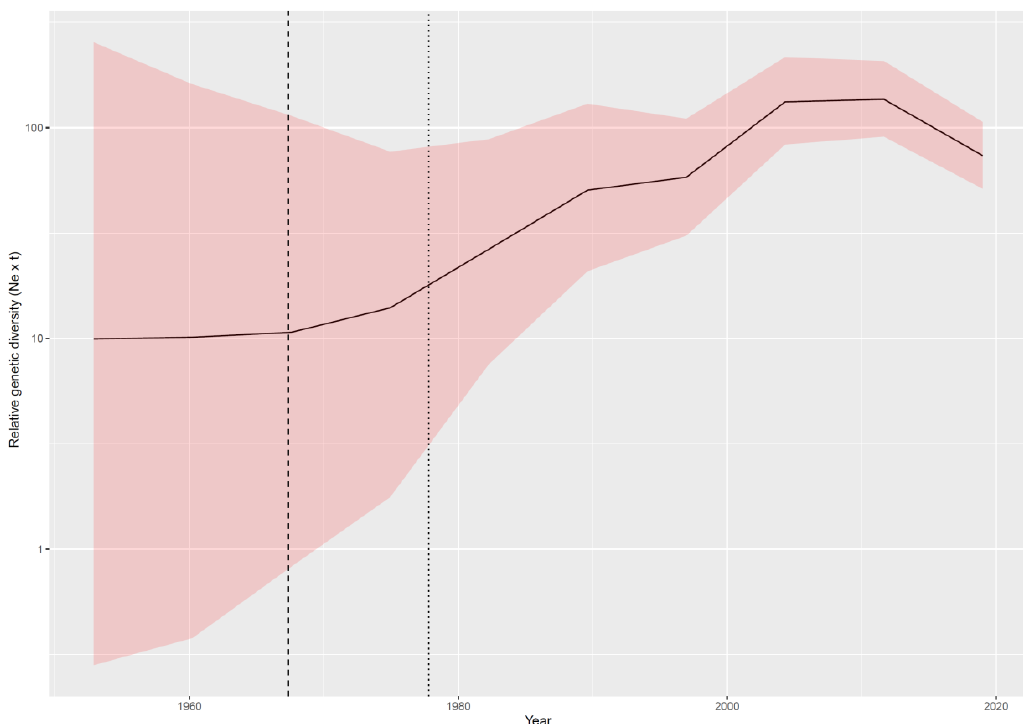
Figure 3. Relative genetic diversity (Ne x t) of the bovine coronavirus (BoCV) population over time. The mean value is reported in black, while the upper and lower 95HPD values are reported as a shaded area. The mean and upper 95HPD values of the time to Most Recent Common Ancestor (tMRCA) are reported as black dotted lines.